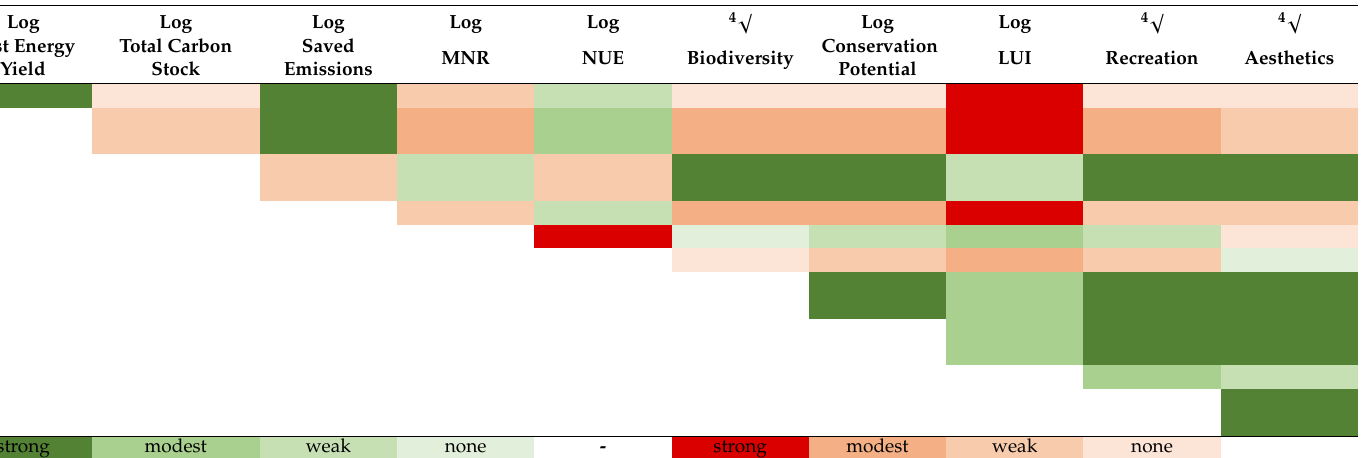
Table 3. Results of the pairwise correlation analysis between ecosystem